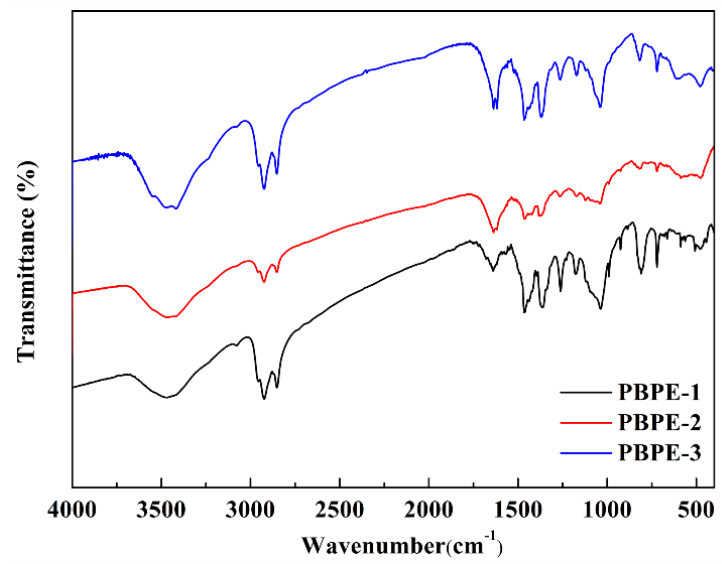
Figure 2. FT-IR spectra of PBPE-1, PBPE-2 and PBPE-3.